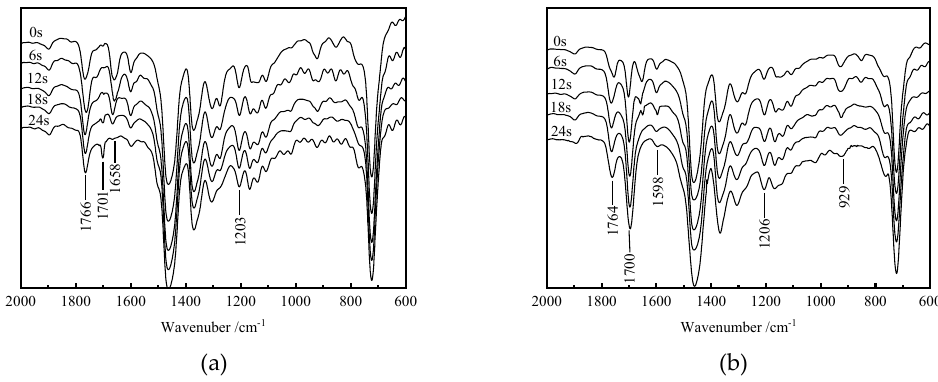
Figure 4. Infrared spectra of photo ‐ initiated crosslinking reaction systems: ( a ) LDPE/BPL; ( b ) Figure 4. LDPE/BPL/STAIC.